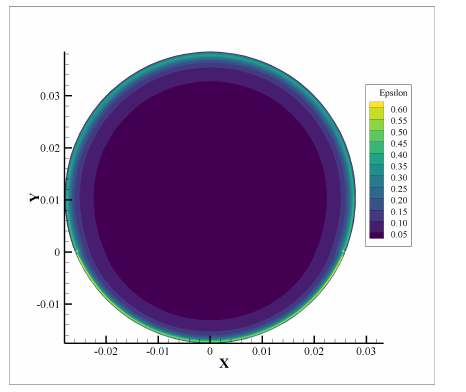
Figure 11. Calculated turbulent kinetic energy distribution of the pipe cross section at mixed velocity 0.43 m/s and water cut 0.25 of SST k − ω turbulence model.